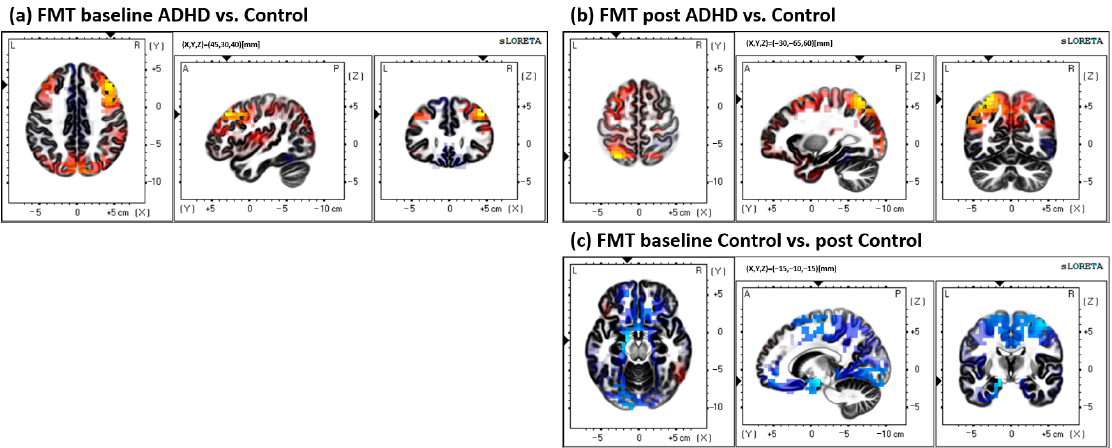
Figure 5. All FMT comparisons. All results yielded were insignificant ( p > 0.05). ( a ) Comparison of baseline activity between groups (ADHD vs. Control; control activity > ADHD activity), differential activity in BA 9, middle frontal gyrus, frontal lobe. ( b ) Comparison of post-acquisition activity between groups (ADHD vs. Control; control activity > ADHD activity); the greatest difference was found in BA 7, superior parietal lobule, parietal lobe. ( c ) Within-group control comparison between baseline and post-acquisition (baseline activity < post activity), greatest activity difference in BA 28, parahippocampal gyrus, and the limbic lobe.